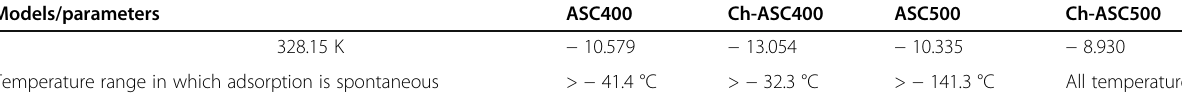
Table 1 Isotherm, kinetic, diffusion, and thermodynamic parameters and determination coefficients (Continued) Models/parameters